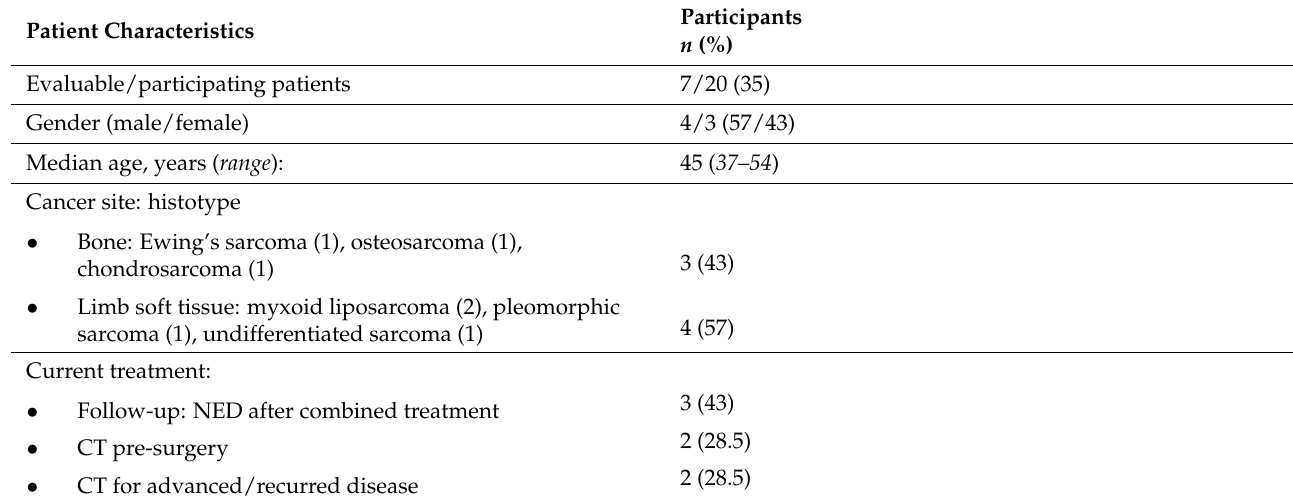
Table 1. Patients’ general